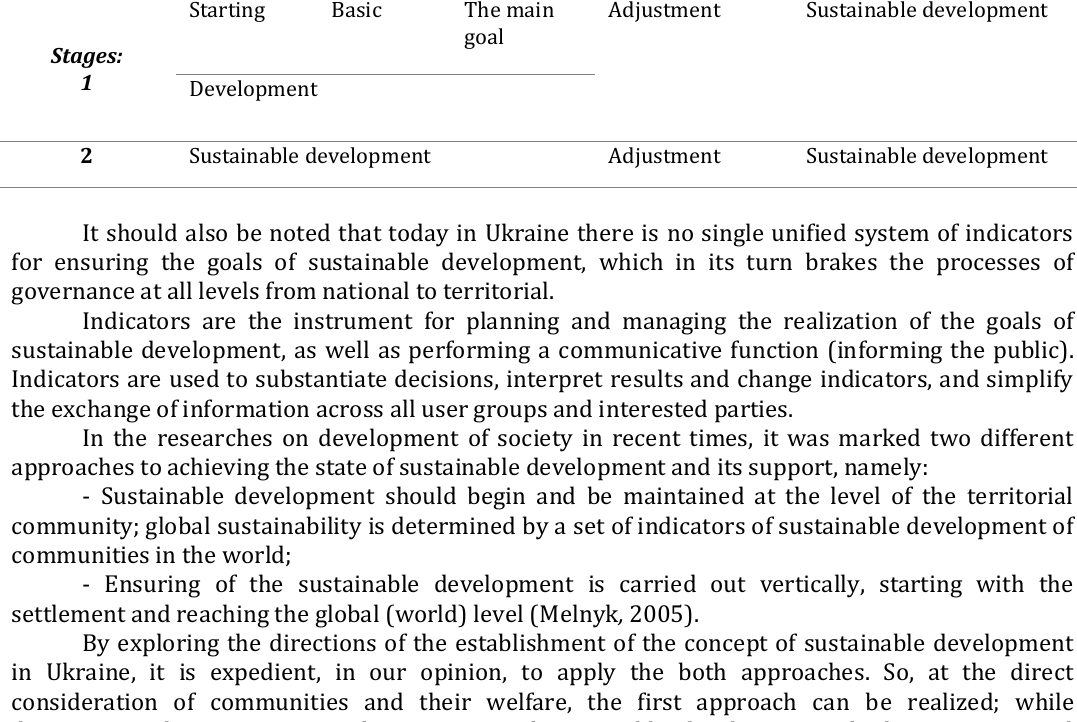
Stages of realization